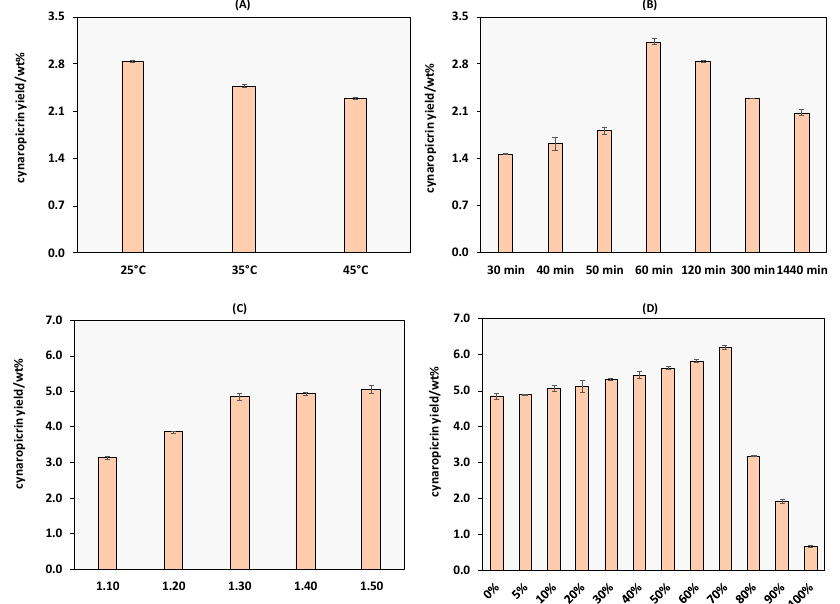
Figure 3. Optimization of cynaropicrin the extraction yields from C. cardunculus leaves using decanoic acid:[N 4444 ]Cl at 2:1: ( A ) temperature ( T ); ( B ) extraction time ( t ); ( C ) solid-liquid ratio (S/L ratio); and ( D ) wt % of water in DES. The results presented correspond to the average of three independent experiments.